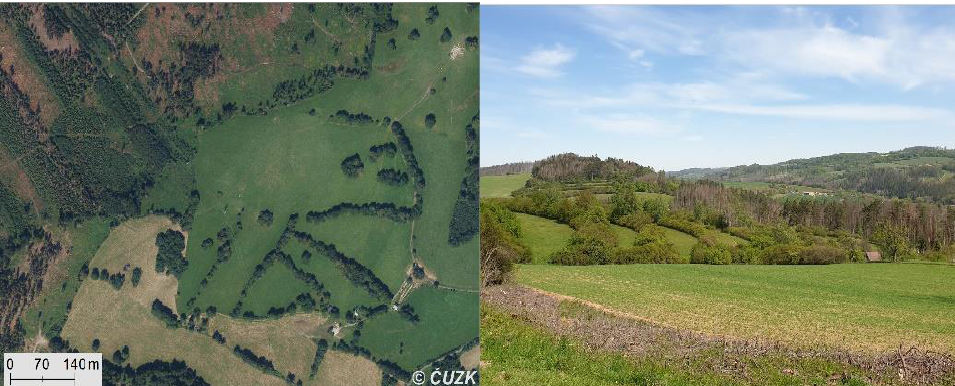
Figure 14. Resistance of naturally evolved broad-leaved woody stand communities in landscapes seriously affected by a bark-beetle outbreak — example from the Jeseníky Mts ( left ) and the Česko- moravská Vrchovina Mts ( right ). Dead forest plantations of European spruce are widespread in both areas [data sources: Orthophoto of the CR, ČÚZK, Praha, Czech Republic, processed in ArcGIS, ESRI, Redlands, CA, USA; photography by Zacharová, 2020].